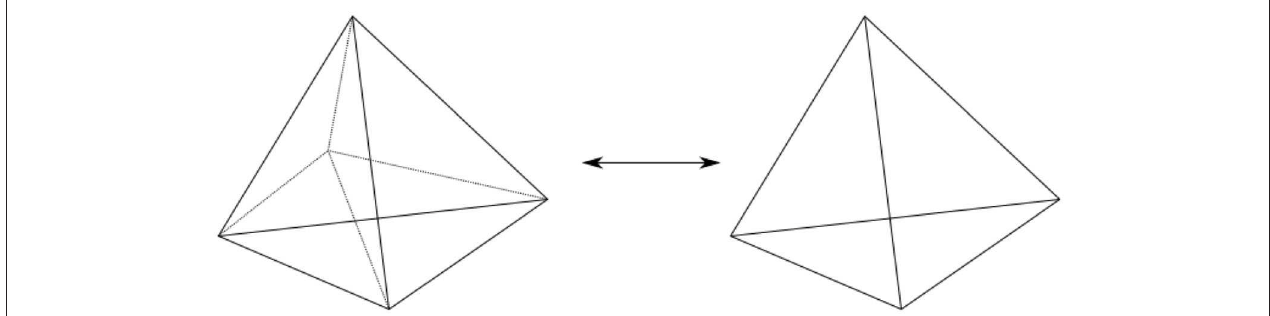
FIGURE 3 | The 4-1 Pachner move in 3D: the 3D Regge action is invariant under this move. Moreover, the configuration on the left hand side possesses a vertex translation symmetry. Three of the edge lengths connecting the inner vertex to the remaining ones can be chosen freely; the fourth one is then uniquely determined.